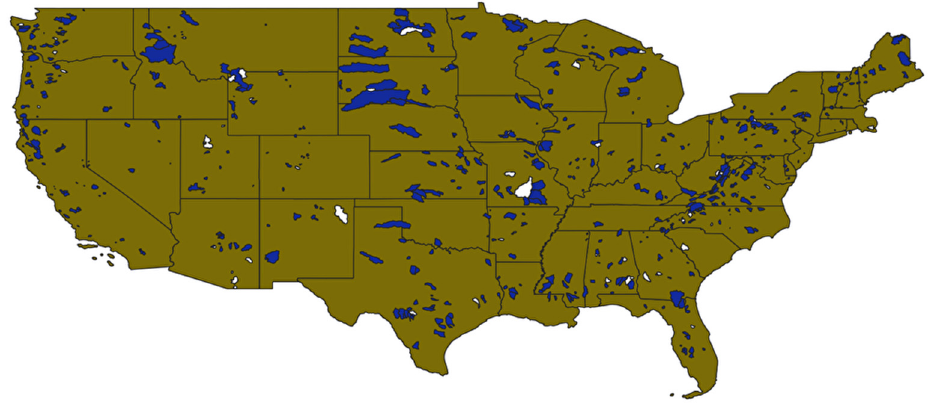
Figure 1. Tested basins in the CAMELS dataset. The blue basins were used, while the white basins were not.